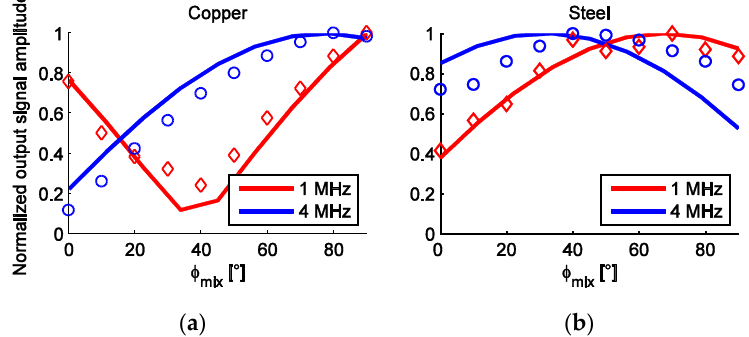
Figure 14. The dependence of φ mix on the U pp 1 microsystem output voltage at 1 and 4 MHz. Lines denote simulated values, while the measured points are marked by circles and diamonds. All amplitude values are normalized. ( a ) Results for copper scale; ( b ) Results for steel scale.